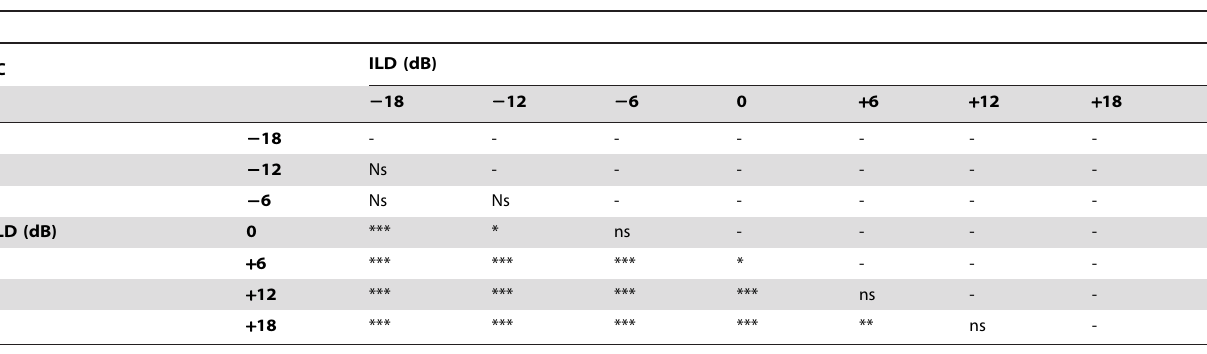
Table 3. IC p-value table.